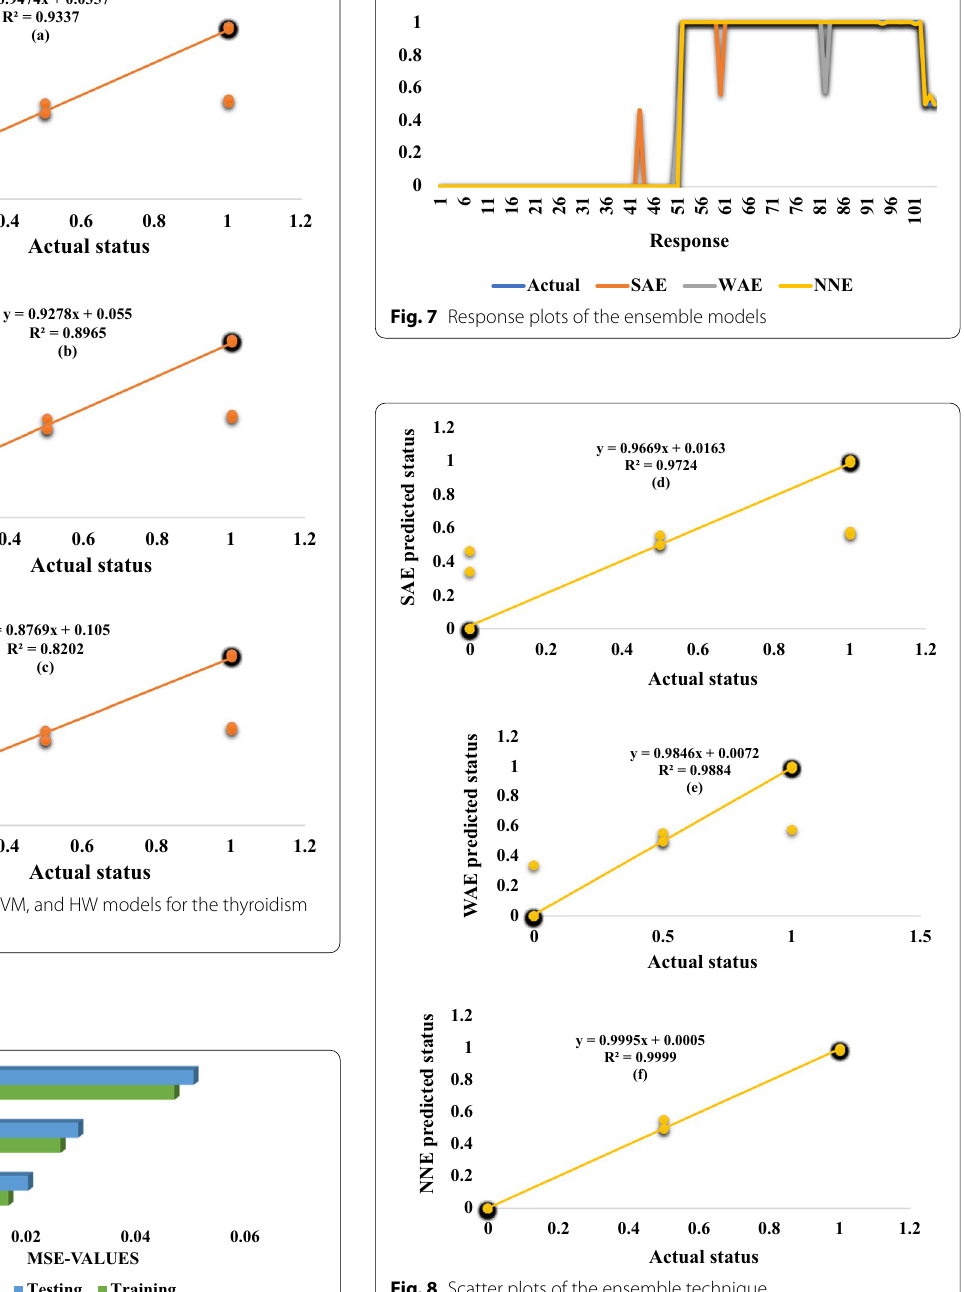
Fig. 6 Visualized comparative error performance of the single models